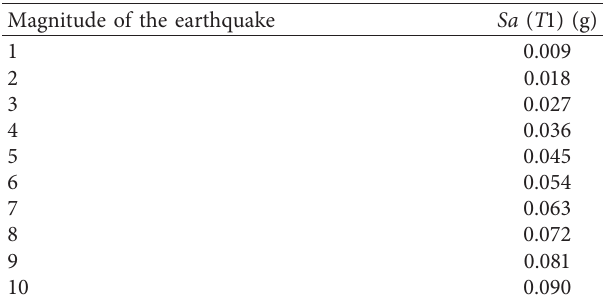
Table 3: Classification of ground motion intensity. Magnitude of the